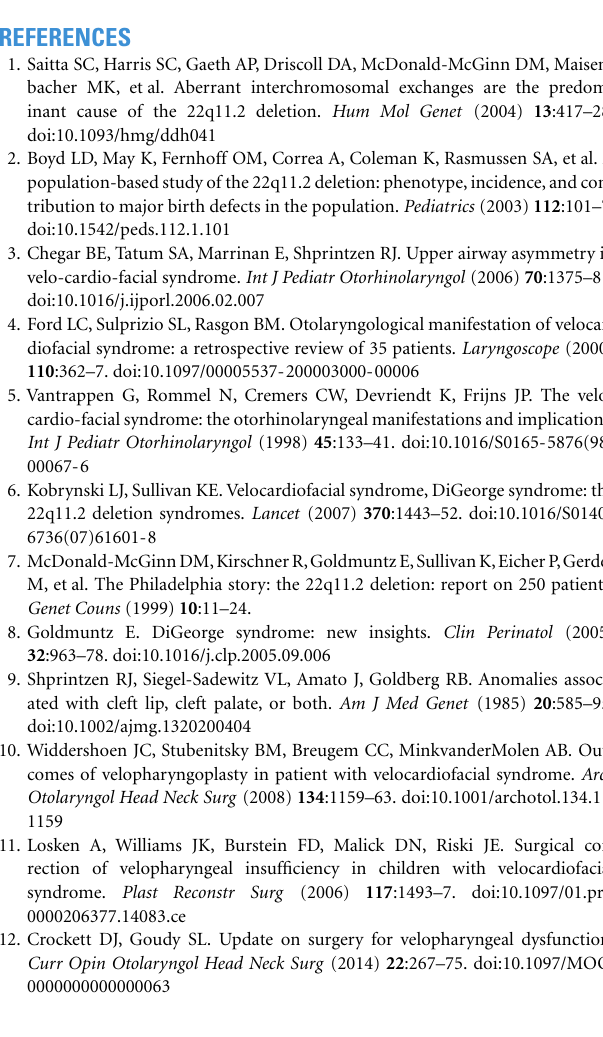
Tonsillectomy 7.0 events/h Conservative Pharyngeal flap 2.4 events/h Conservative PSG = polysomnography, AHI = apnea/hypopnea index, OSA = obstructive sleep apnea,T&A = tonsillectomy and adenoidectomy, MPG = midline posterior glossec- tomy, LT = lingual